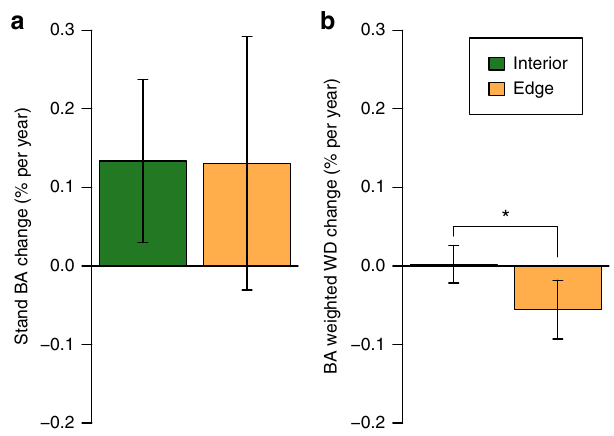
Fig. 5 Mean changes in stand basal area and basal area weighted mean wood density in forest interior and close to anthropogenic edges in Borneo. Stand basal area (BA, a ) and BA weighted mean wood density (WD, b ) were calculated on a proportional basis relative to values of the initial censuses of long-term plots in Borneo. Plots were classi fi ed as edge affected if within 448 m from anthropogenic edges. Values represent long- term trends (mean monitoring period 1988 – 2010) estimated using linear mixed effects (LME) models. Bars are 95% CIs. Asterisk indicates signi fi cant difference ( P = 0.011). Individual plot values for these variables are presented as histograms in Supplementary Fig. 5 showing variation in both interior and edge